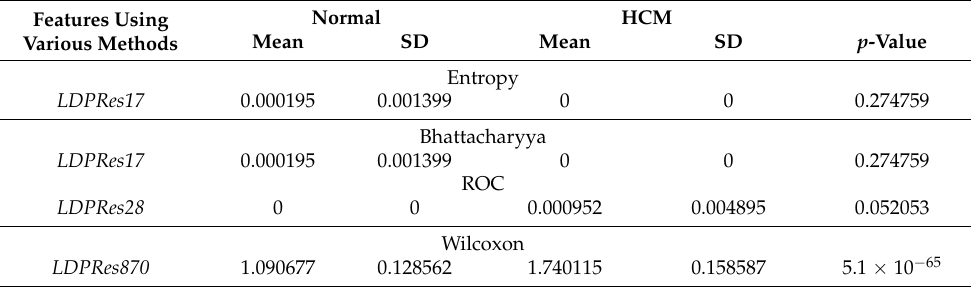
Table 5. Highest-ranked features using various ranking